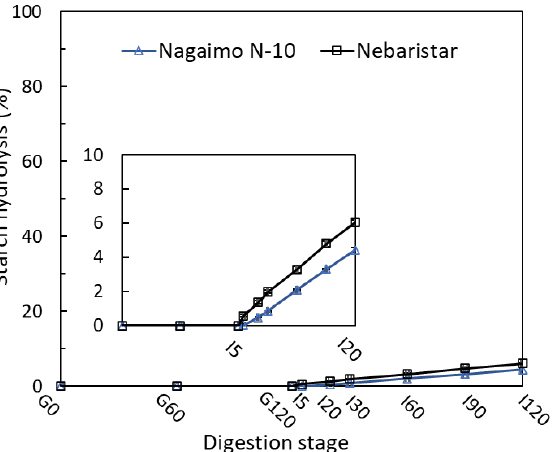
Figure 1. Changes in starch hydrolysis (%) of the raw yam tubers during simulated in vitro digestion. Starch hydrolysis is closely related to its gelatinization, and a higher degree of gela- tinization had a positive effect on SH [17]. Starch structural disruption would occur under heat treatments such as boiling, steaming and microwaving, leading to a high SH. The results found in the current study suggested that raw yam tubers would not induce a fast glycemic increase for consumers, although they contain a high total starch content of 67.3% for Nagaimo N-10 and 72.4% for Nebaristar (Table A1). This also indicates that eating raw yam could be beneficial for consumers who have requirements for their body’s blood sugar